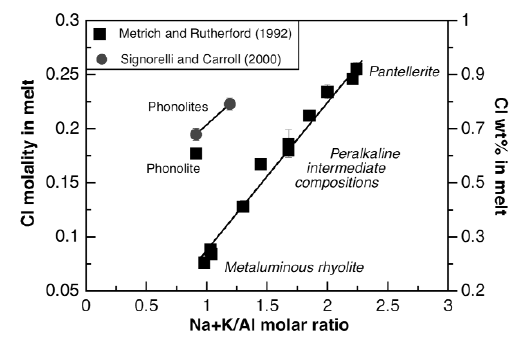
Fig. 5. Solubility of chlorine at 100 MPa as a func- tion of molar (Na+K)/Al ratio for natural rhyolites and phonolites saturated with an aqueous fluid + hy- drosaline brine (data from Metrich and Rutherford, 1992; and Signorelli and Carroll,